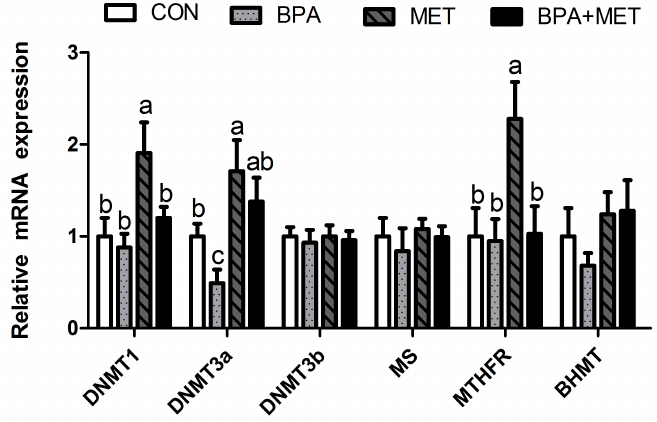
Figure 2. Effect of maternal methyl donor or bisphenol A supplementation during gestation on mRNA relative expression of key enzymes related to DNA methylation in jejunum of newborn piglets. CON, control; BPA, bisphenol A; MET, methyl donor; BPA + MET, both bisphenol A and methyl donor supplementation in control diet; DNMT , DNA methyl transferase; MS , methionine synthase; MTHFR , methylenetetrahydrofolate reductase; BHMT , betaine homocysteine methyltransferase. Data are normalized against β -actin , with results expressed relative to the control sample using the ∆∆ C t method (where C t is the cycle threshold) with efficiency correction. Values are expressed as mean ± standard error; different superscript letters within a row indicate significant difference ( p < 0.05). 12 independent samples per treatment group (total 48).